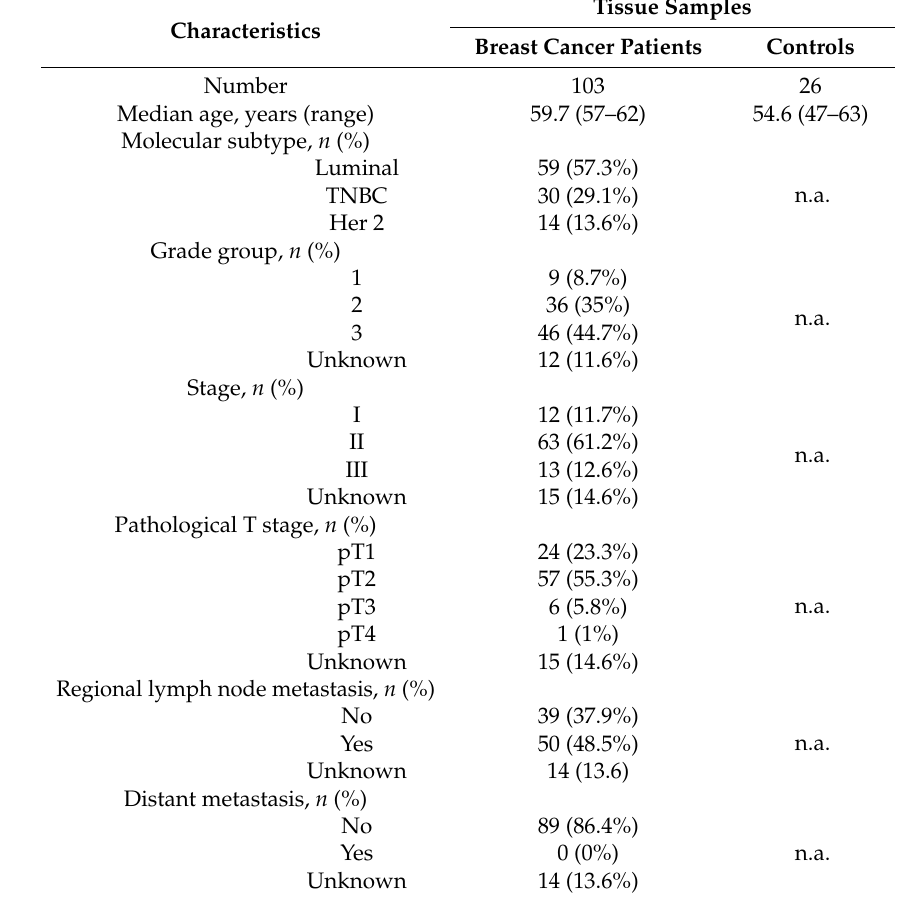
Table 1. Clinicopathological characteristics of breast cancer patients and controls in discovery cohort: cohort #1.